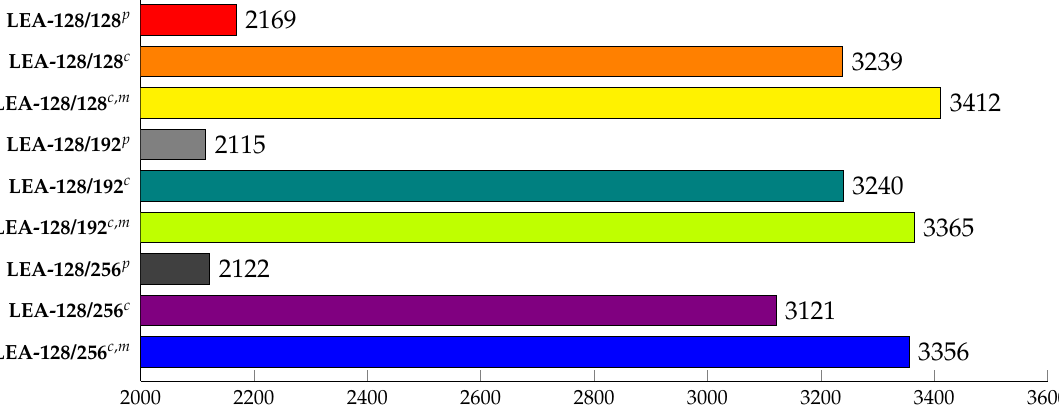
Figure 21. Comparison of throughput (MB/s) for LEA implementations on GPU platform including memory copy time, where p , c , and m represent parallel ECB mode of operation, parallel CTR mode of operation, and GPU memory optimization, respectively.(LEA-n/m means n-bit plaintext encryption with the m-bit